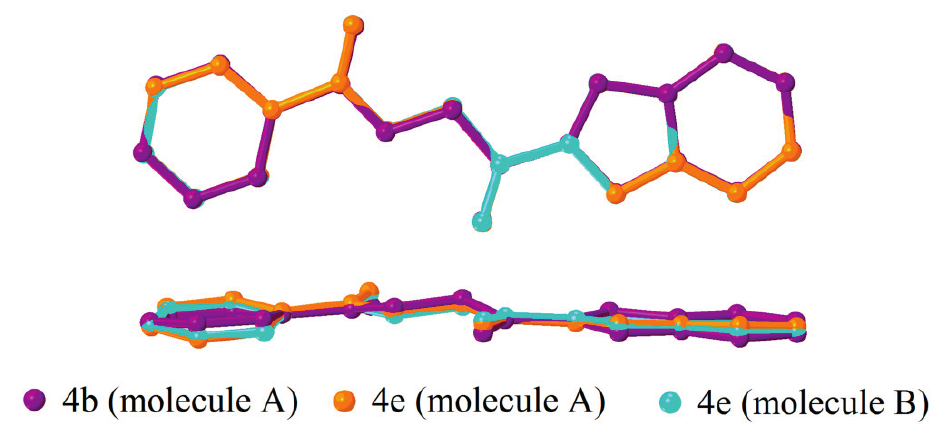
Figure 2. Overlay diagram of 4a , 4b (inverted molecule B), 4c and 4d shows similar, nearly-perpendicular conformation.